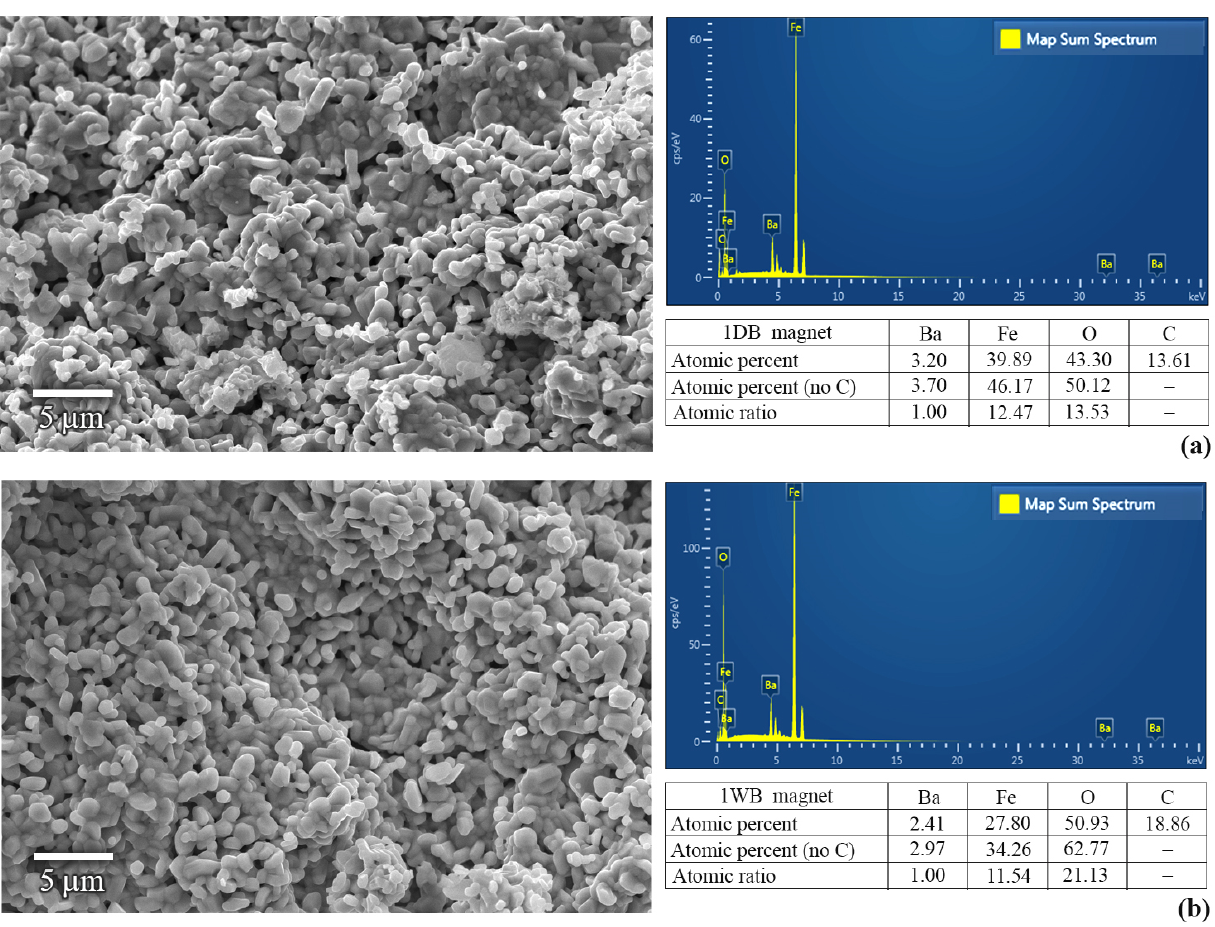
Figure 3. XRD spectra of the dry- and wet-pressed bar magnets (1DB and 1WB), and magnets from paste-injection molding (2C0, 2CP4 and 2CP5).